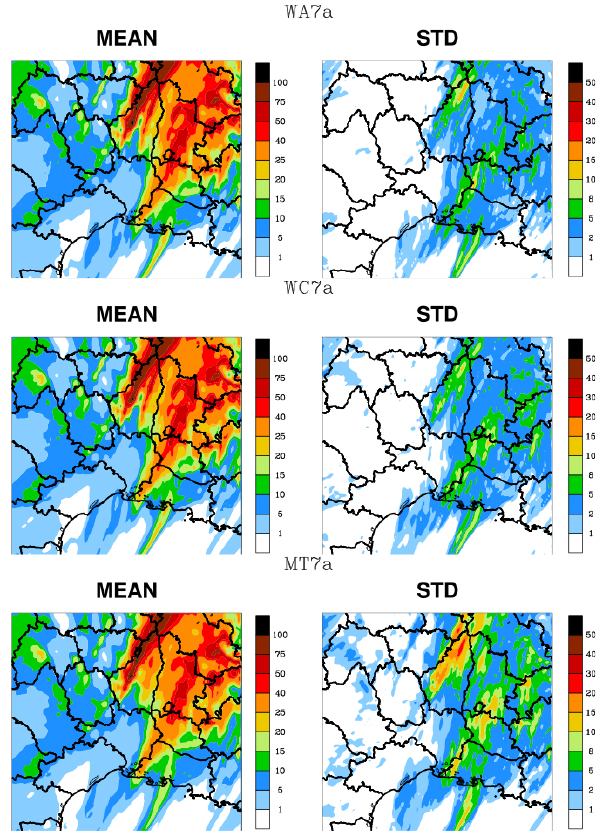
Fig. 13. Mean and standard deviation of the 24h accumulated rain- fall for the WA7a (top), WC7a (middle) and MT7a (bottom) ensem- bles.